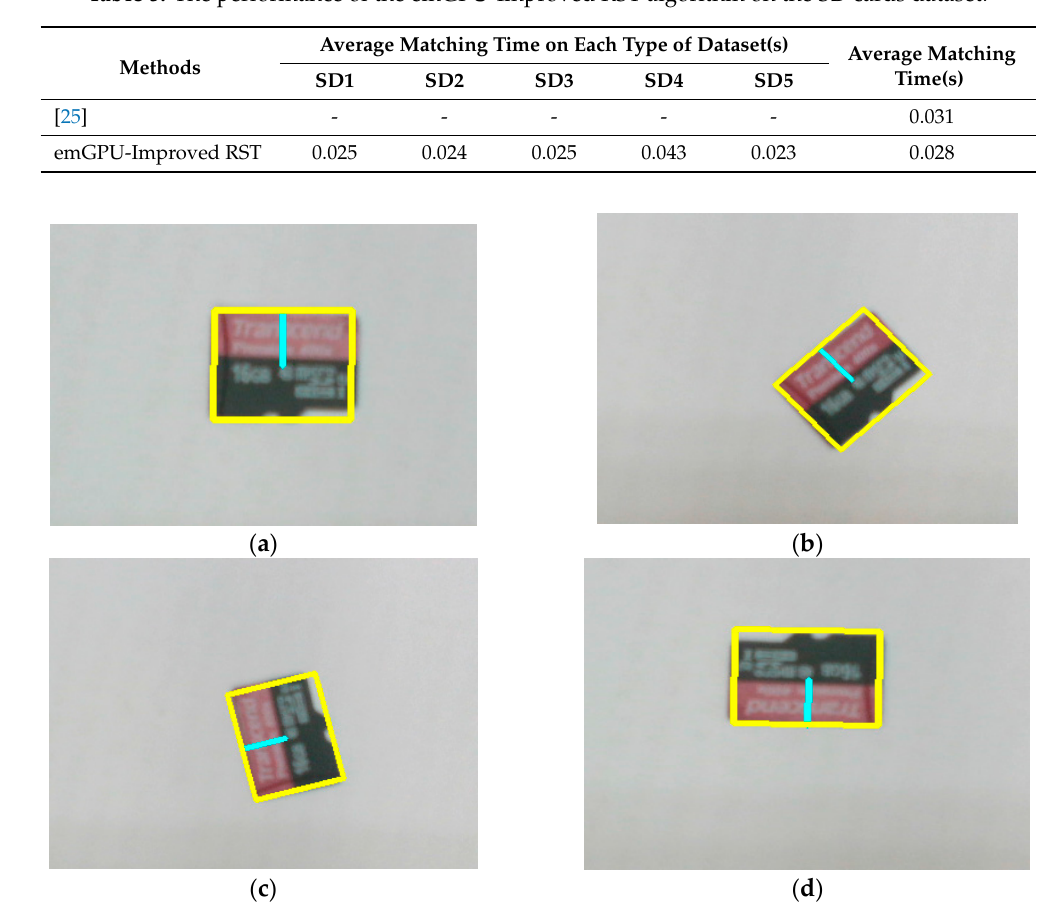
Figure 12. Matching results on the SD cards dataset: (a), (b), (c) and (d) show matching results with different angles.